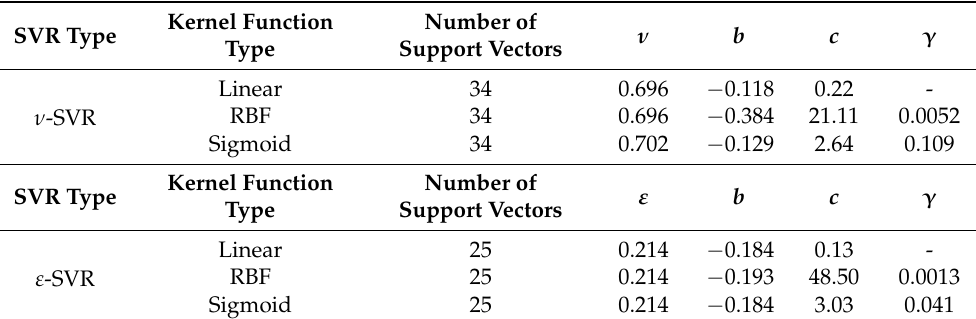
Table 4. Optimized parameters of ν -SVR and ε -SVR with three types of kernel functions on the prediction of COD removal